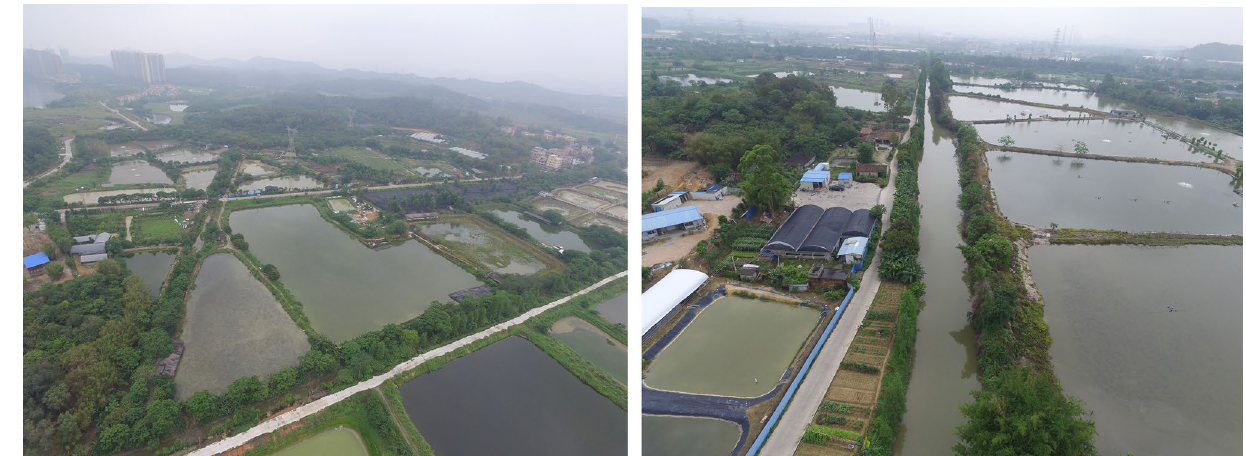
Fig.15 Dike-pond landscape. (Photo by the